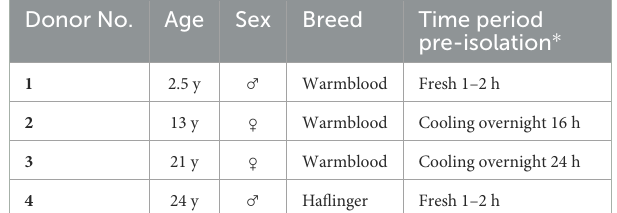
TABLE 1 Details of donors used for isolation. Donor